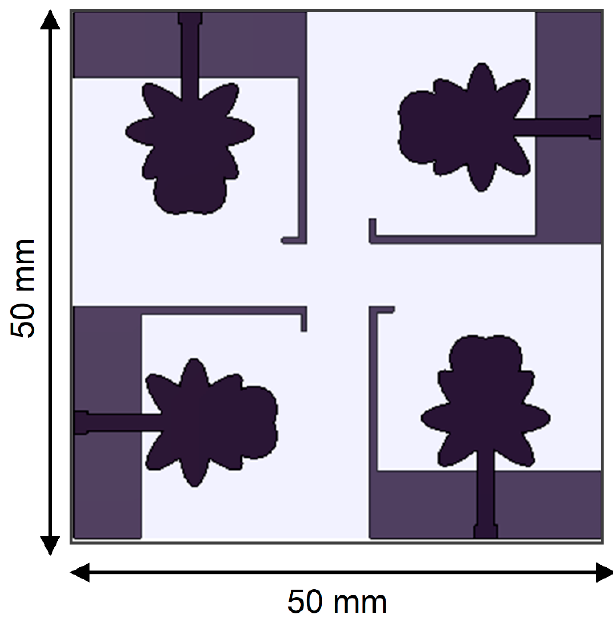
Figure 6. Quad-port UWB multiple-input-multiple-output (MIMO) antenna.